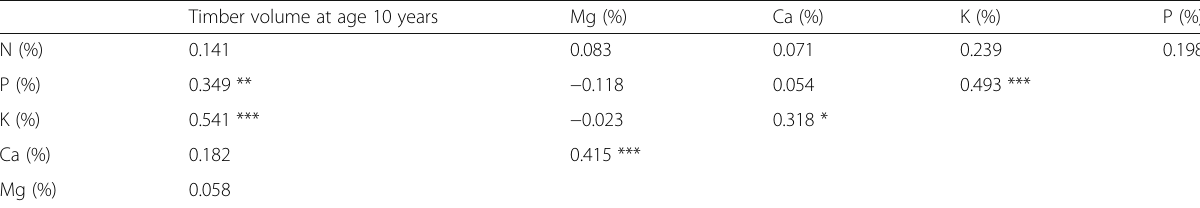
Table 6 Correlation coefficients and statistical significance of relationship between needle nutrient concentration (%) and volume production at age 10 years across all treatments and sites of the first trial series established in